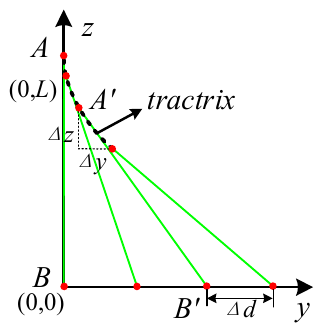
Figure 4. Trajectory-tracking principle.